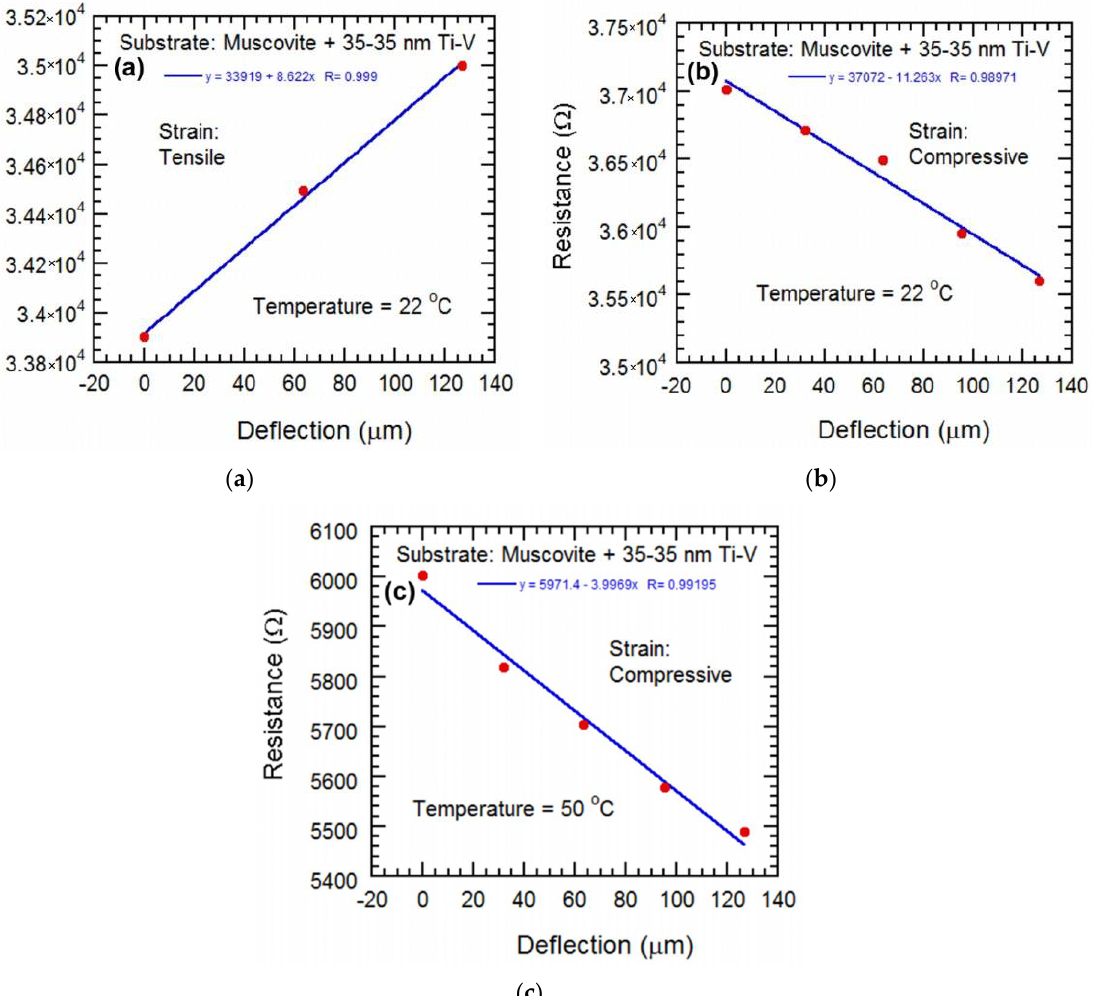
Figure 3. ( a ) The effect of tensile train on the resistance between two contacts on Ti–doped VO 2 at 22 °C (room temperature). The effect of compressive strain on the resistance of Ti–dope d VO 2 on muscovite ( b ) at 22 °C (room temperature) and ( c ) at 50 °C (transition region).